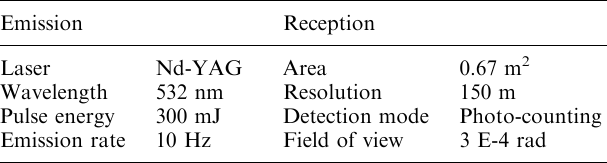
Table 1. Lidar characteristics in late